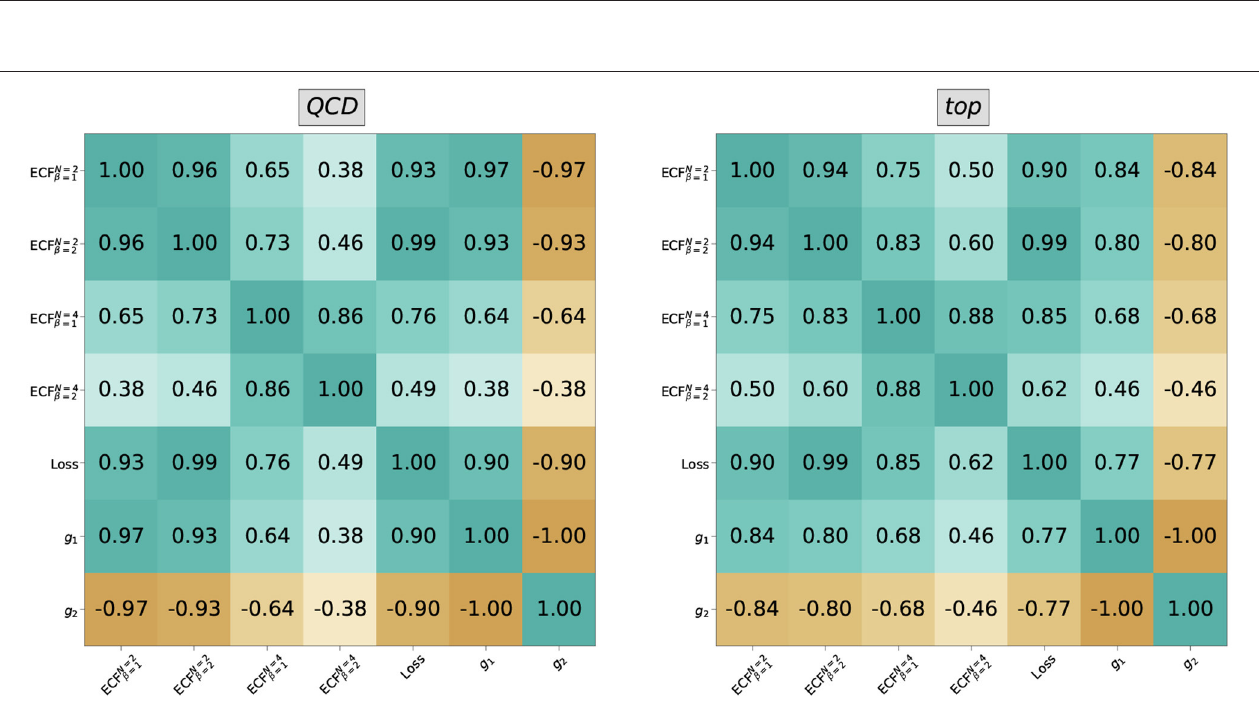
FIGURE 4 | The distribution of each dimension of the two-dimensional latent spaces obtained after an IRC safe graph readout given in Equation (12).